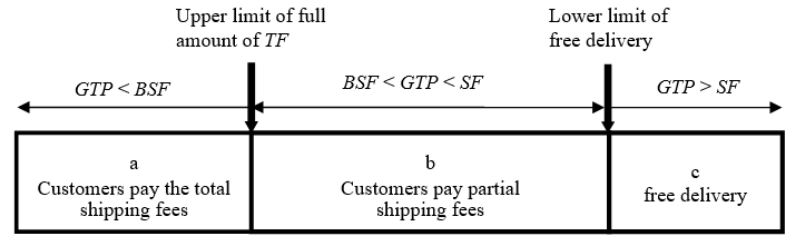
Figure 1. Partial shipping fees pricing model illustration.